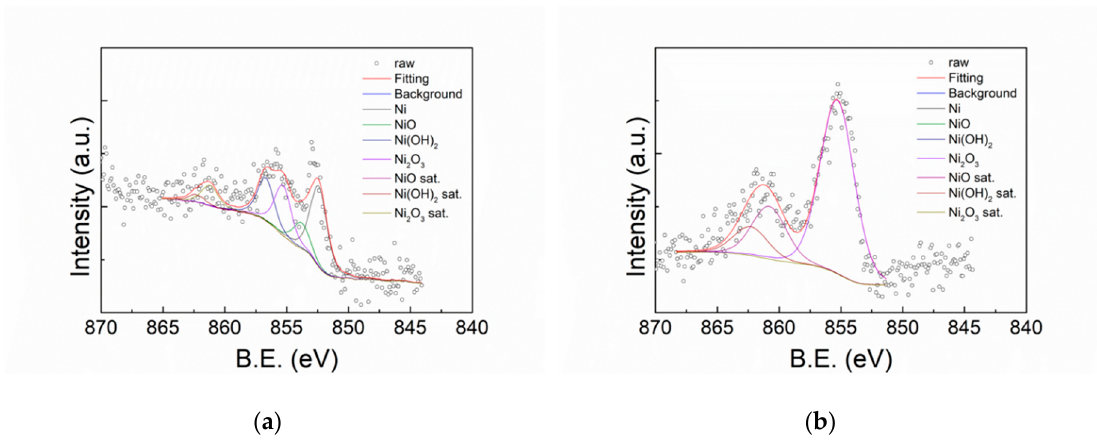
Figure 10. XPS Ni2p spectra of ( a ) FeCoNiCr and ( b ) APPJ-treated FeCoNiCr MEAs.